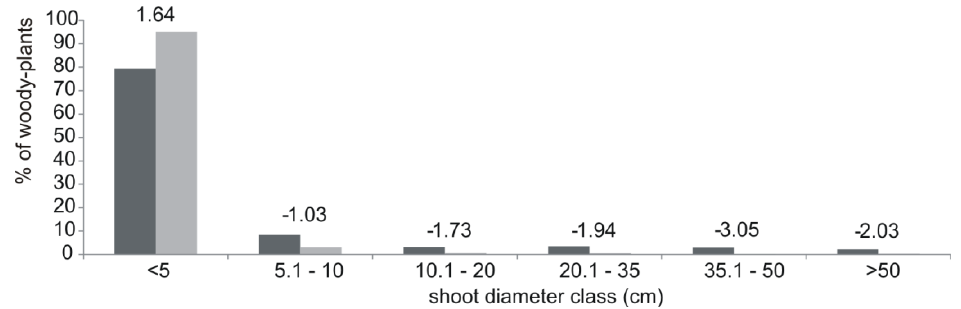
Figure 1. Woody plant genera available (in dark gray) and browsed by beavers (in light gray) with the electivity values (Ivlev’s electivity ind ex with Jacob ’ s modification) in all the transects located along the Gwda River. Only the genera with an abundance above 0.5% are included in the figure.